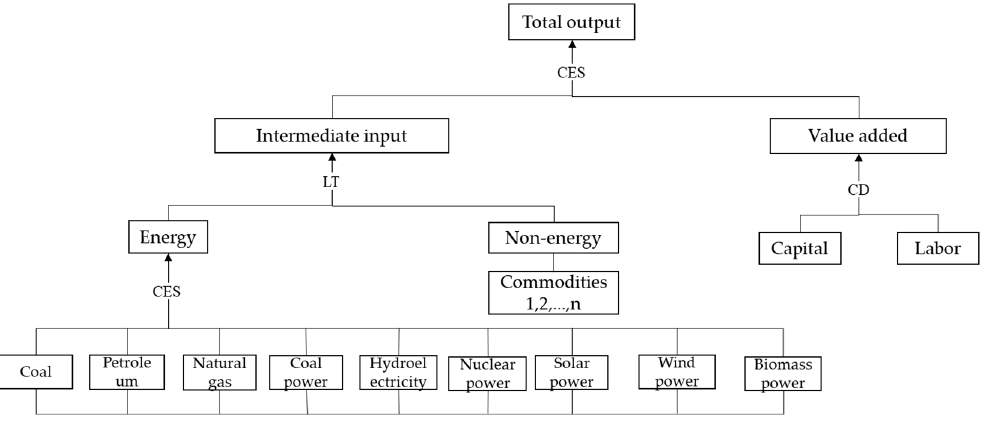
Figure 3. Production block of 3EF-CGE model.